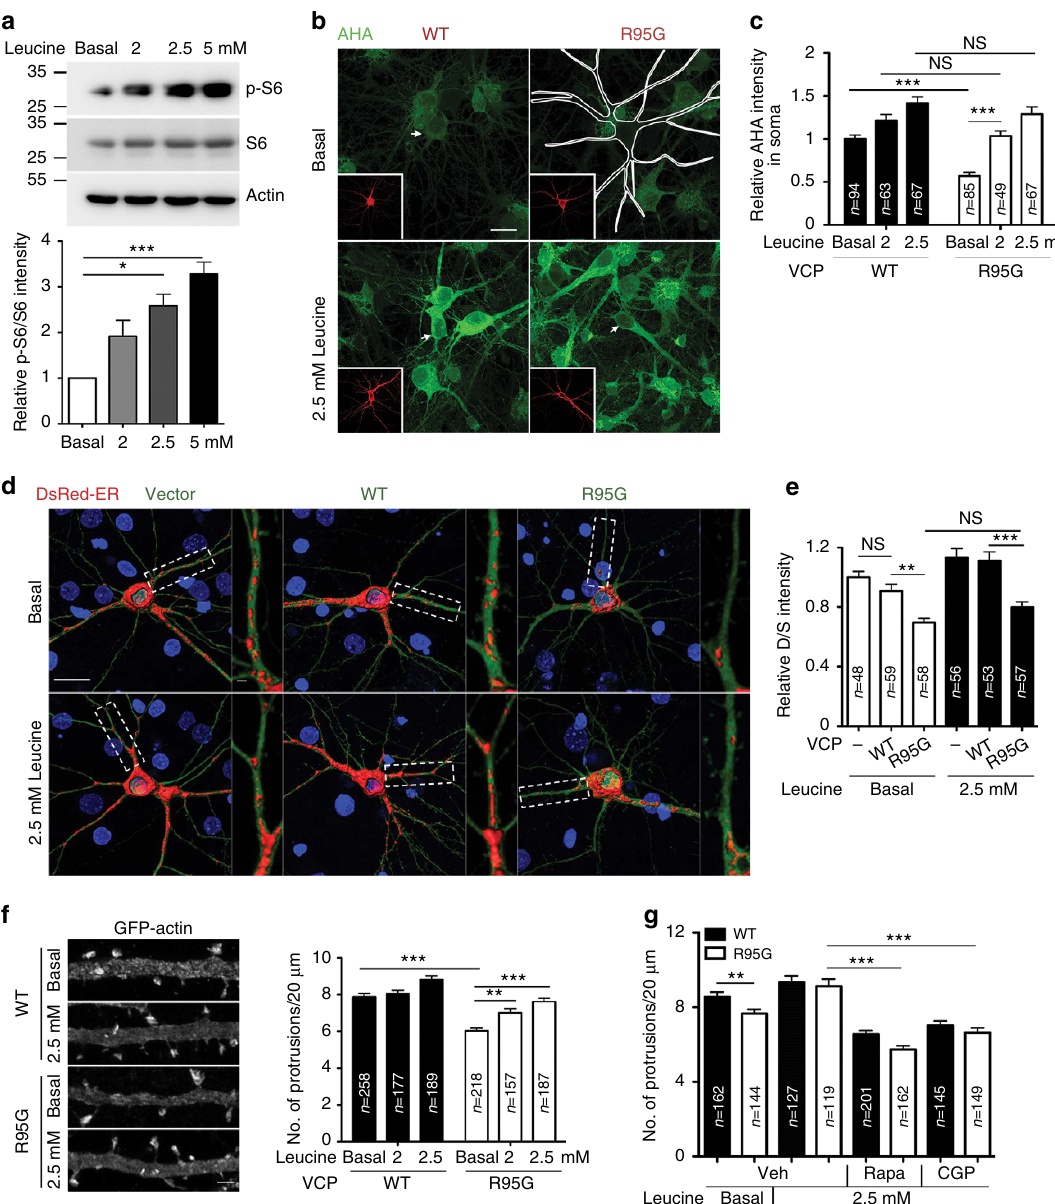
Figure 9 | Leucine supplementation ameliorates the deficits in protein synthesis and dendritic spine density of Vcp -deficient neurons. ( a ) Increased leucine concentrations in the medium induce the phosphorylation of S6 ribosomal proteins in the cultured neurons. The basal leucine concentration in Neurobasal medium is 0.8mM. Full-size blots are shown in Supplementary Fig. 9. ( b – g ) Cultured neurons were transfected with the indicated plasmids at 12 DIV, treated with different concentrations of leucine at 15 DIV and analyzed for ( b , c ) AHA incorporation, ( d , e ) ER distribution and ( f , g ) dendritic spine density at 18 DIV. Full-size cell images of ( f ) are shown in Supplementary Fig. 7a. In ( b ), the transfected neurons in the images are either outlined or indicated by arrows. ( g ) Rapamycin (Rapa; 10nM) and MNK1 inhibitor CGP57380 (CGP; 10 m M) were added 6h before harvesting to reduce the beneficial effect of leucine on dendritic spine density. Full-size cell images of ( g ) are shown in Supplementary Fig. 7b. Scale bars, ( b , d ) 20 m m; ( d ), enlarged and ( f ) 2 m m. The data from three independent experiments are presented as the mean þ s.e.m. (error bars). The sample sizes ( n ) of the examined neurons ( c , e ) and dendrites ( f , g ) are indicated. * P o 0.05; ** P o 0.01; *** P o 0.001; NS, non-significant. One-way ANOVA ( a ); two-way ANOVA ( c , e , f , g